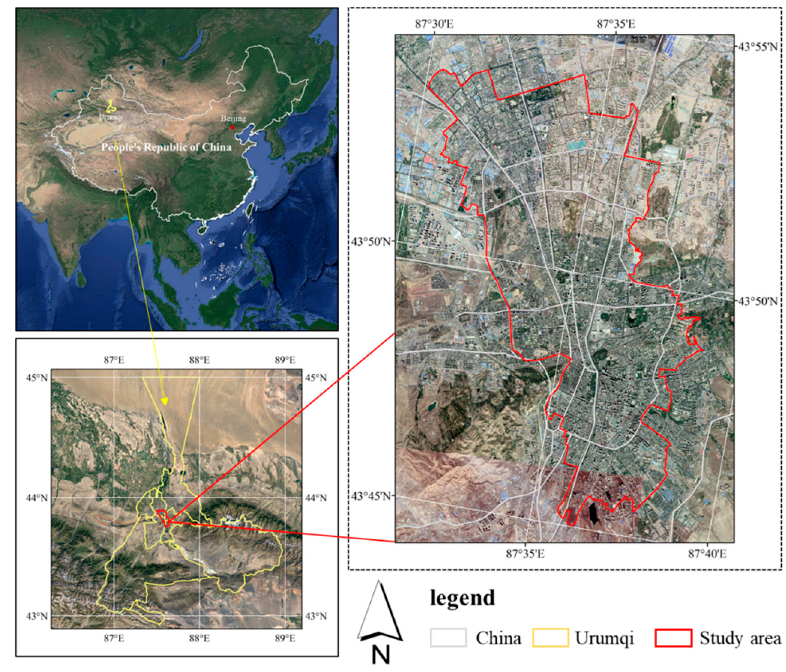
Figure 1. Study area: Urumqi, China (based on map sources: GS (2020)3183).